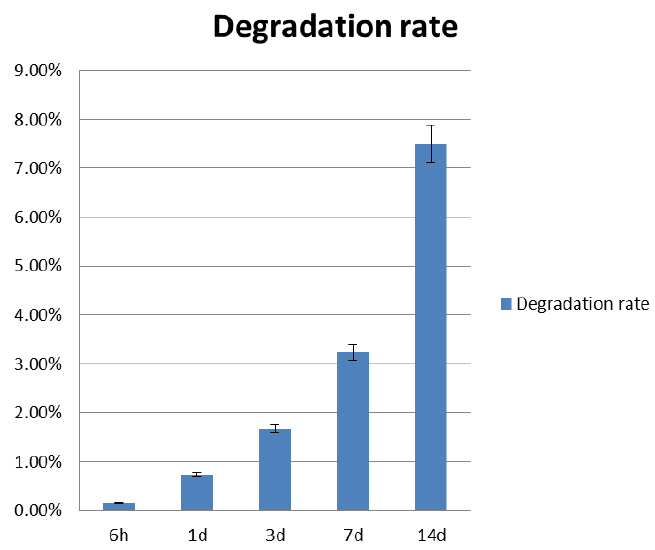
Figure 3. Degradation rate of the fabricated constructs.